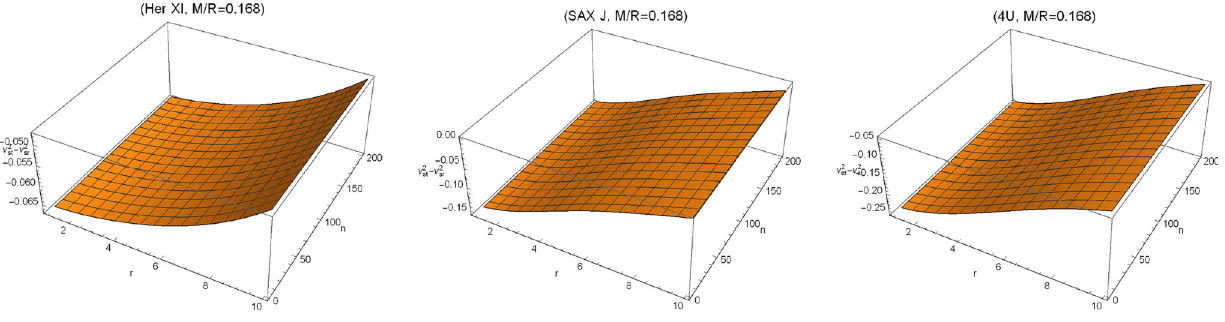
− υ 2 Fig. 13 Behavior of υ 2 sr with radial coordinate r (km) and model parameter n in different compact stars st